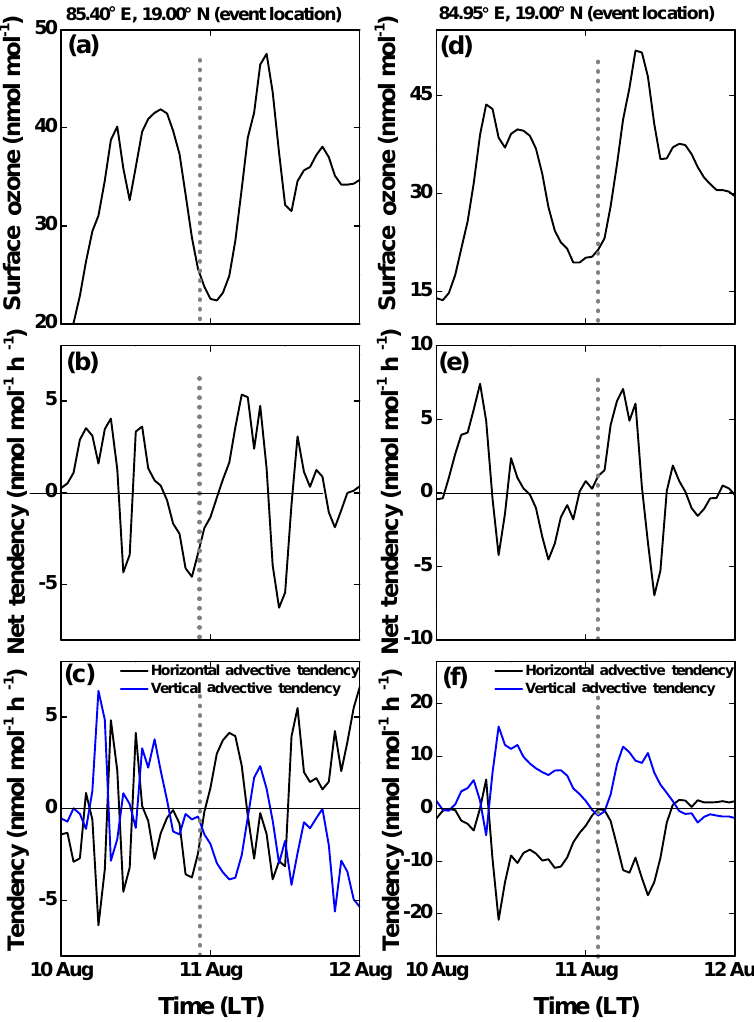
Figure 10. Time series of surface O 3 (a) and various tendency terms ( b and c ) over the event location during the fourth low-O 3 event, as obtained from WRF-Chem simulations. (d) – (f) are the same as (a) – (c) , but for another location during the same event. These two event locations are also marked by triangles in Fig. 11. Vertical dotted line shows the time of the event in the in situ observations of surface O 3 over the indicated